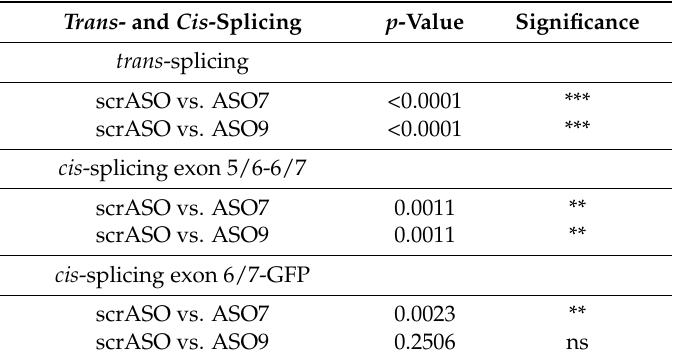
Figure 7. Comparison of rationally designed ASOs on RNA level. ( A ) sqRT-PCR analysis revealed a ~4-fold increase in GFP expression in ASO7 and a ~2-fold increase in ASO9-treated cells in comparison to cells treated with the scrambled ASO. An unpaired Student’s t -test (two-tailed) was performed with GraphPad Prism software (GraphPad Software, San Diego, CA, USA) to prove the statistical significance between scrASO and ASO7, as well as scrASO and ASO9 (Table 5). The cis -splicing activity within the Ex5/6-Ex6/7 KRT14 -scMG region was significantly decreased for ASO7 and ASO9. Within the Ex6/7-GFP region the cis -splicing activity was decreased for ASO7 but unaffected for ASO9; ( B ) the co-delivery of the KRT14 -scMG, the KRT14 -scRTM, and different ASO7 concentrations into HEK232 cells resulted in the most promising trans -splicing efficiency at an ASO concentration of 60 nmol. HEK293 cells treated with the screening constructs and respective scrambled ASO concentrations were set to 1. Significance values are given in asterisks (** p -value ≤ 0.01; *** p -value ≤ 0.001). Table 5. Statistical significance cis -splicing Figure 7.